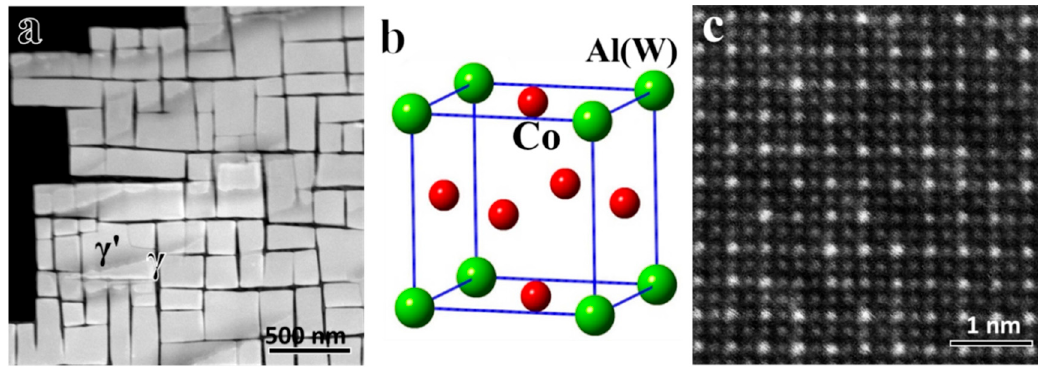
Figure 1. ( a ) High-angle annular dark field (HAADF) image of Co-Al-W-Ti-Ta alloy; ( b ) atomic model of L1 2 - γ ´-Co 3 (Al,W) structure; ( c ) high-resolution HAADF image on the γ ' phase.